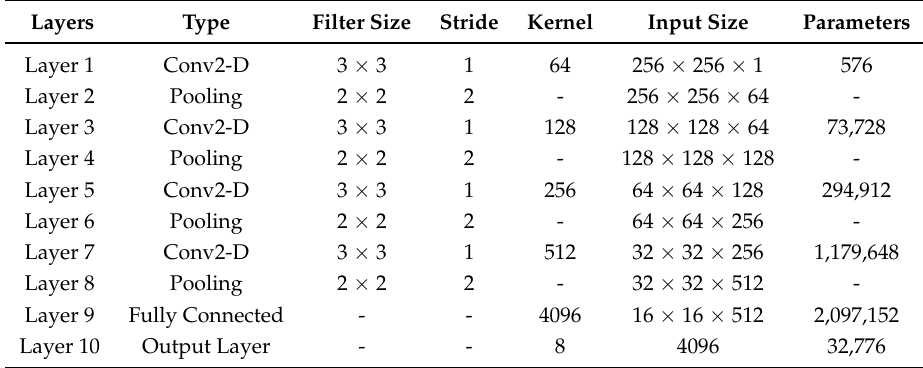
Figure 2. The architecture of the proposed convolutional neural network (CNN) model architecture. Table 1. Details of the layers used in the proposed CNN model